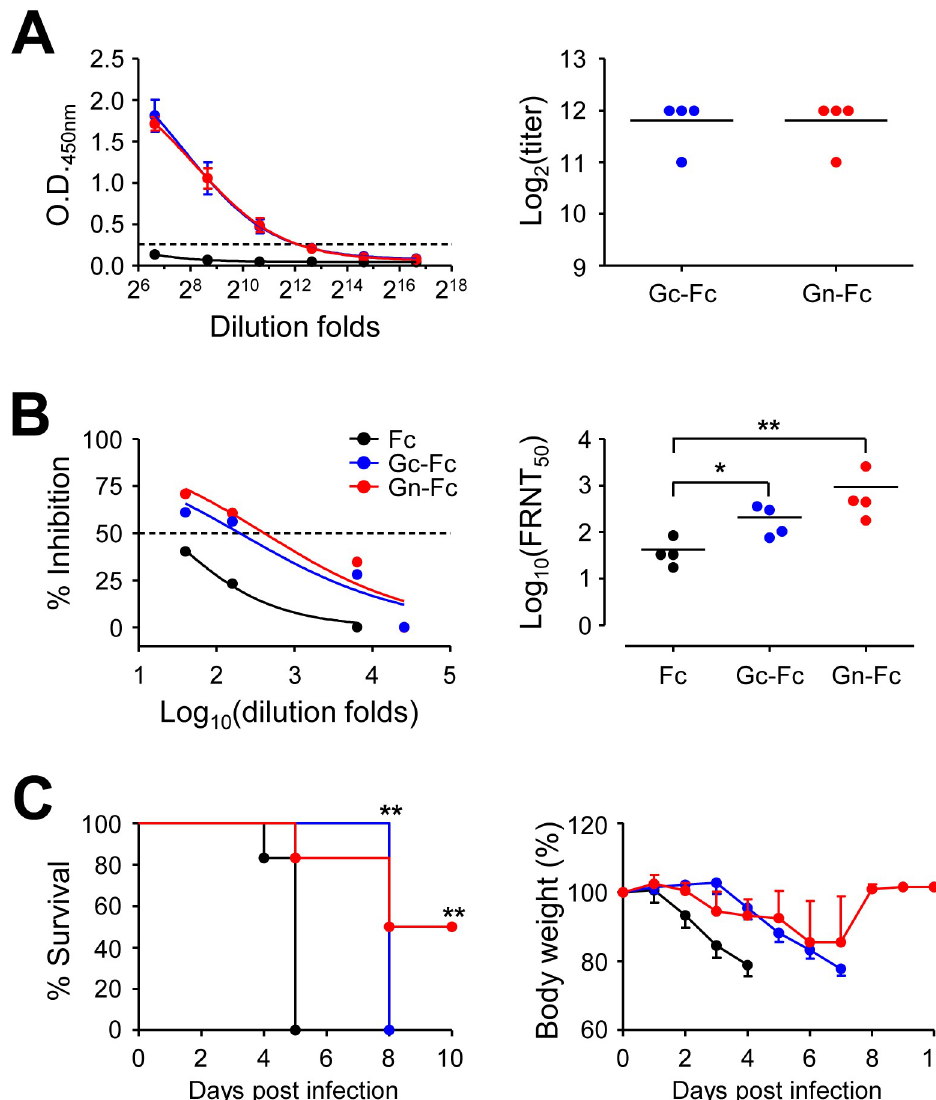
Fig 5. Partial protection of IFNAR KO mice after vaccination with Gn-Fc antigen. (A) Anti-Gc (blue dots) or Gn (red dots) IgG response was measured by ELISA at two weeks after the third immunization with Gn-Fc or Gc-Fc in IFNAR KO mice ( n = 4/group). Cut-off titers (dashed line, mean O.D. + 3 x S.D. at 1:100 diluents) was determined using Fc-immune sera (black dots). The antibody titers of anti-Gc or Gn IgG in sera of immunized mice are summarized in the right panel. Error bar, mean + S.D.; black line, mean. (B) Neutralizing antibody response to SFTSV generated by SFTSV DNA vaccines in IFNAR KO mice. The amount of neutralizing antibody against SFTSV was determined based on FRNT 50 (left panel) and summarized (right panel). (C) Survival rates (left panel) and body weight changes (right panel) of mice immunized three times with Fc (black dots, n = 6), Gc-Fc (blue dots, n = 4), or Gn-Fc (red dots, n = 6) antigen and challenged s.c. with 10 5 FFU of SFTSV at two weeks after vaccination. � , p < 0.05; �� , p <